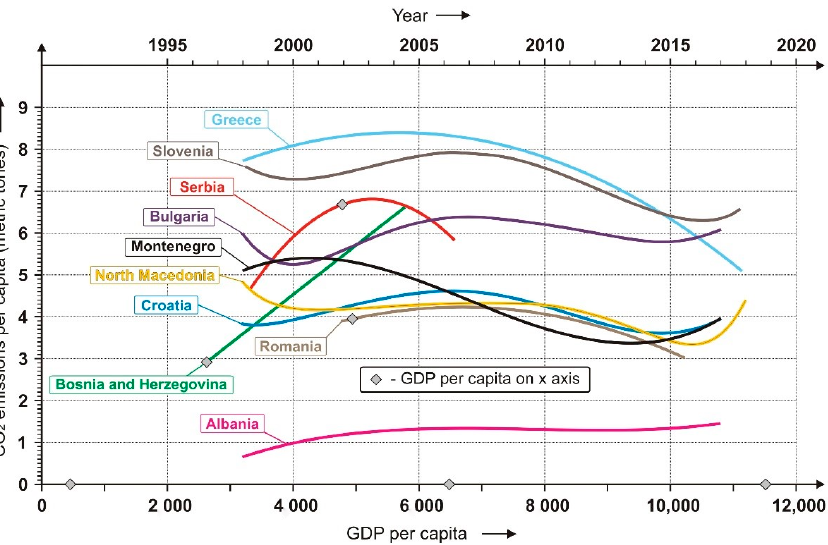
Figure 5. Relationship between CO 2 emissions per capita and GDP per capita in ten Balkan countries (1998–2019) (Authors’ creation).